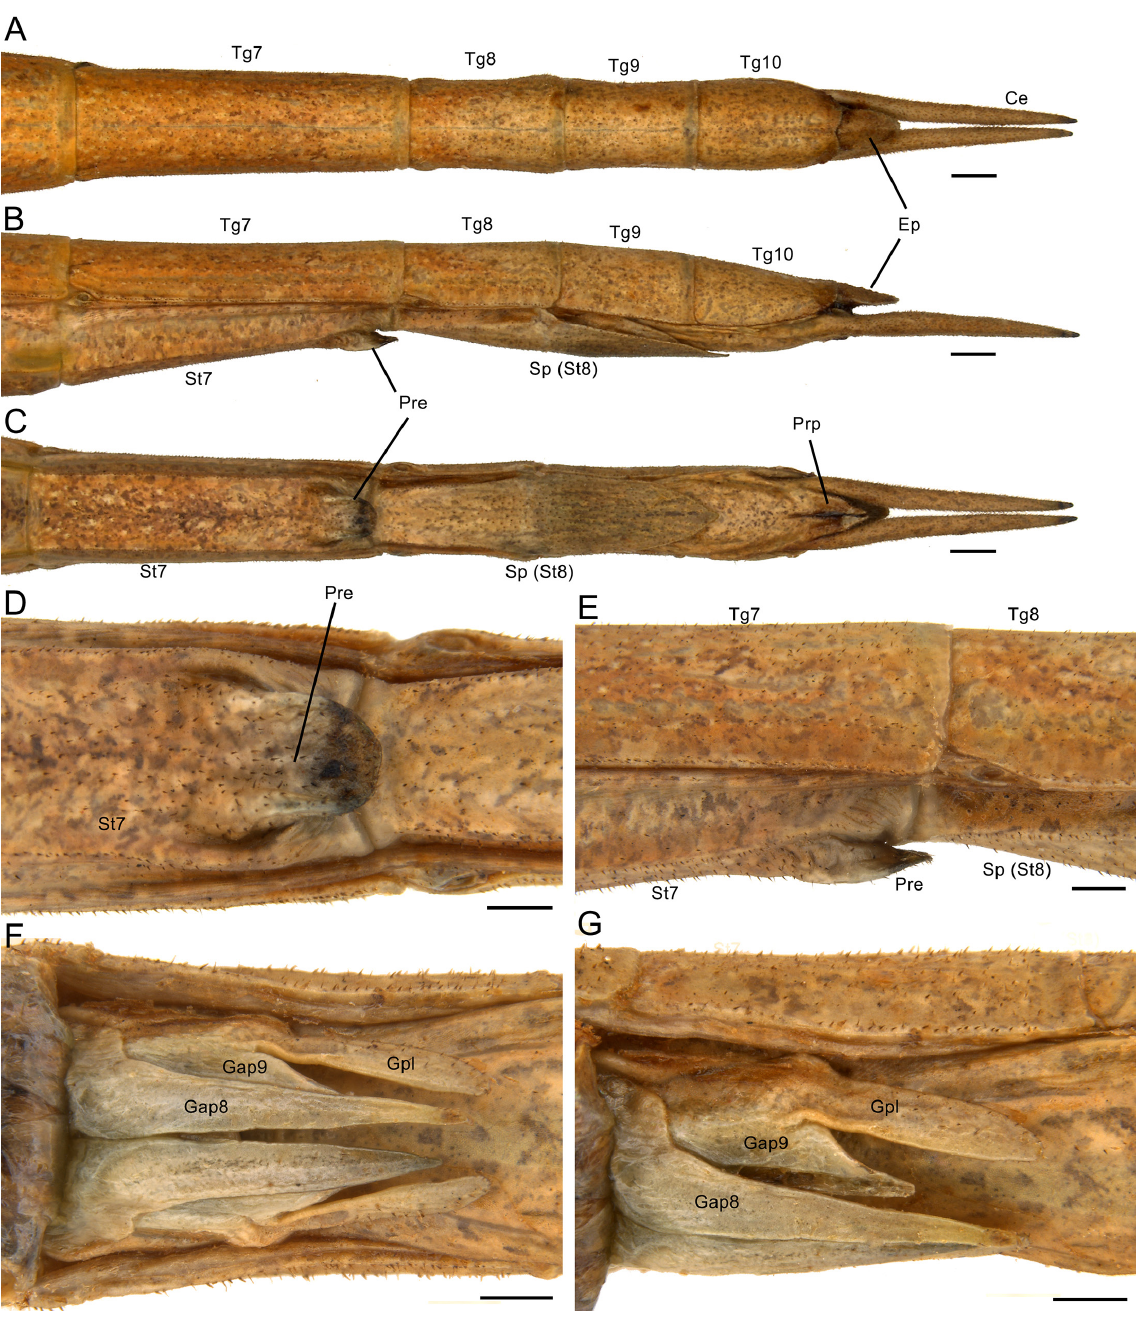
Fig. 37. Arumatia motenata Ghirotto gen. et sp. nov., holotype, ♀ (MZUSP V0603), terminalia morphology. A . Dorsal view. B . Lateral view. C . Ventral view. D–E . Detail of praeopercular organ, ventral (D) and lateral view (E). F–G . Detail of external genitalia, ventral (F) and lateral view (G). Abbreviations: Ce = cercus; Ep = epiproct; Gap = gonapophysis; Gpl = gonoplac; Pre = praeopercular organ; Prp = paraproct; Sp = subgenital plate; St = sternum; Tg = tergum. Scale bars: A–C = 1 mm; D–G = 0.5